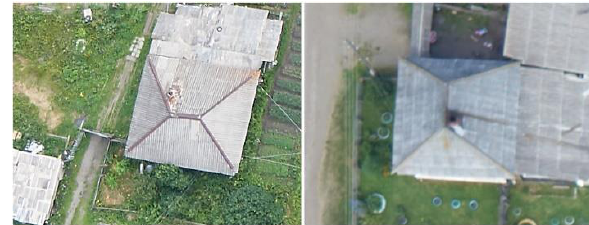
Figure 3. An example of edge transitions in the area of illumination, they should not be used them for assessing the images sharpness Motion blur is a special case of image blurring. It is characterized by blurring in one direction, usually in the direction of camera’s moving.